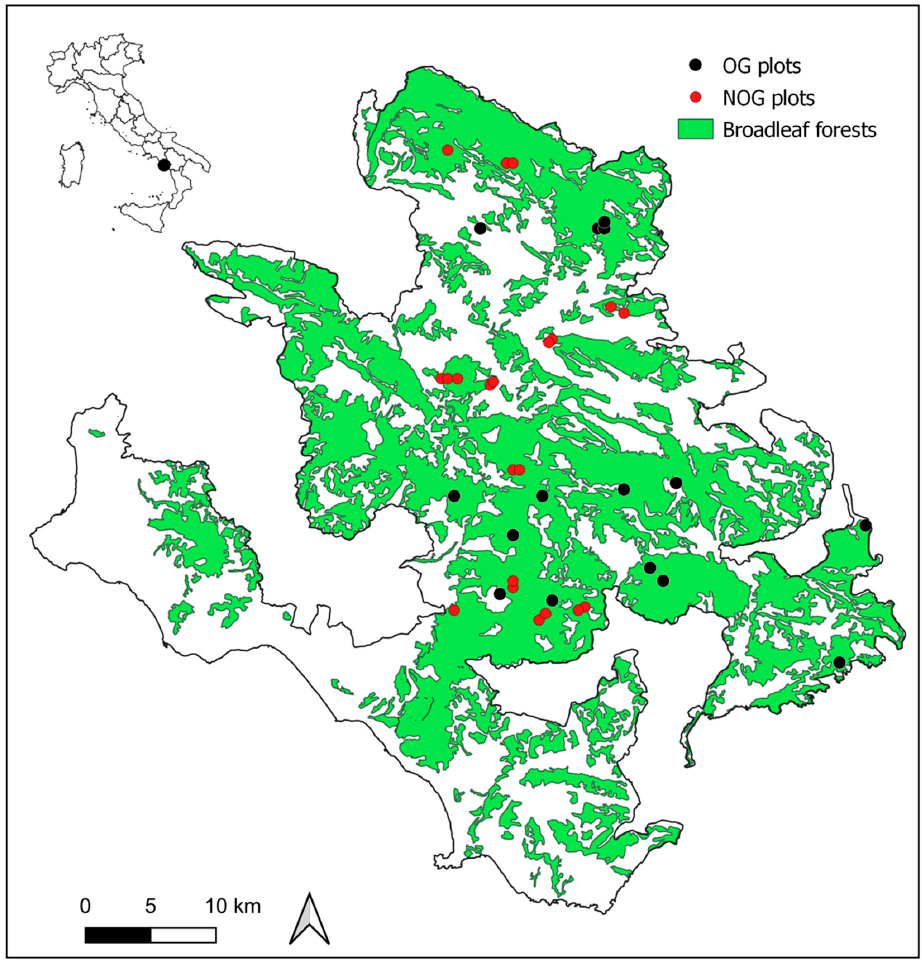
Figure 2. Study area: Cilento National Park (South Italy), with 36 sampling plots. Table 1. Descriptive statistics of the structural variables included in the models. Results of the Wilcoxon test performed for the two forest types are also reported. n.s.: not significant ( p > 0.05). Structural Variables